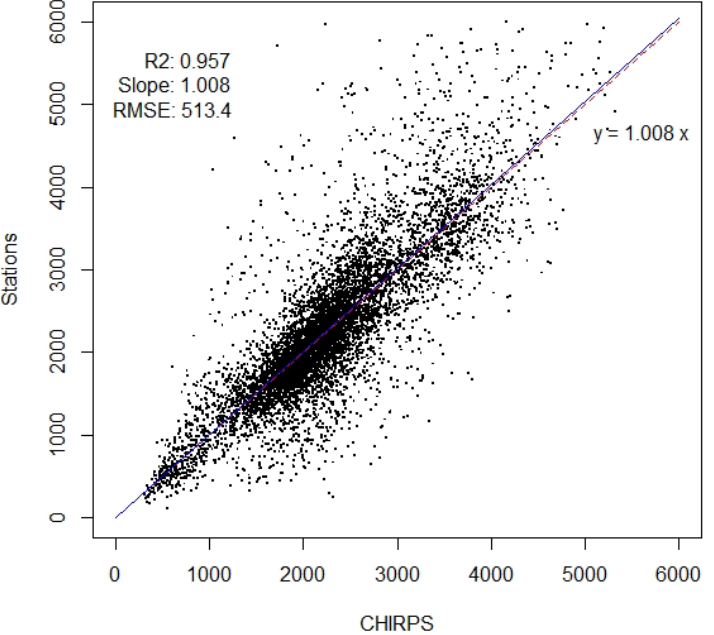
Figure 2. Absolute annual mean values from CHIRPS and the in-situ precipitation (P) stations (black points), with one-to-one (blue) and trend (red) lines.